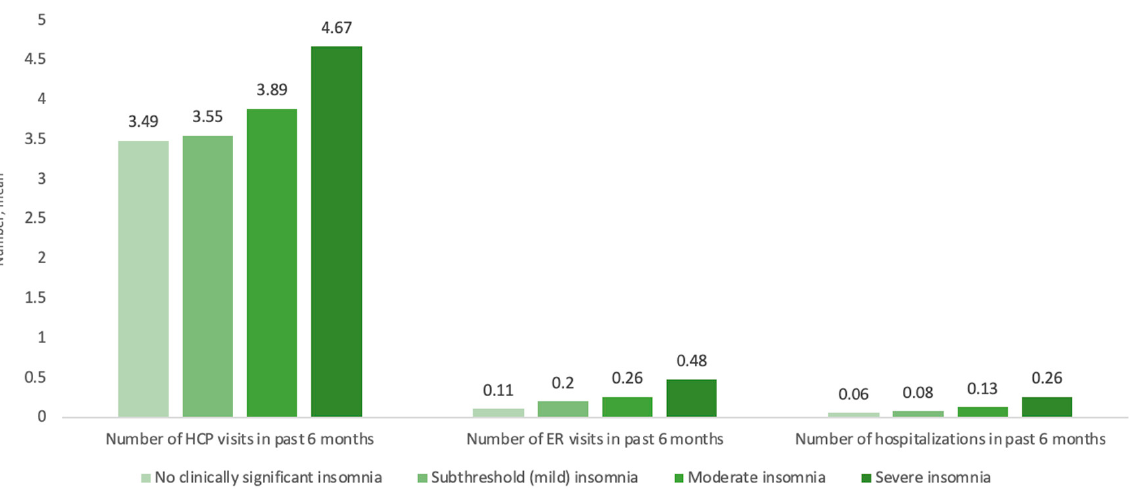
Figure 3. Association between HCRU by insomnia severity category. Abbreviations: ER, emergency room; HCP, healthcare professional; HCRU, healthcare resource utilization.